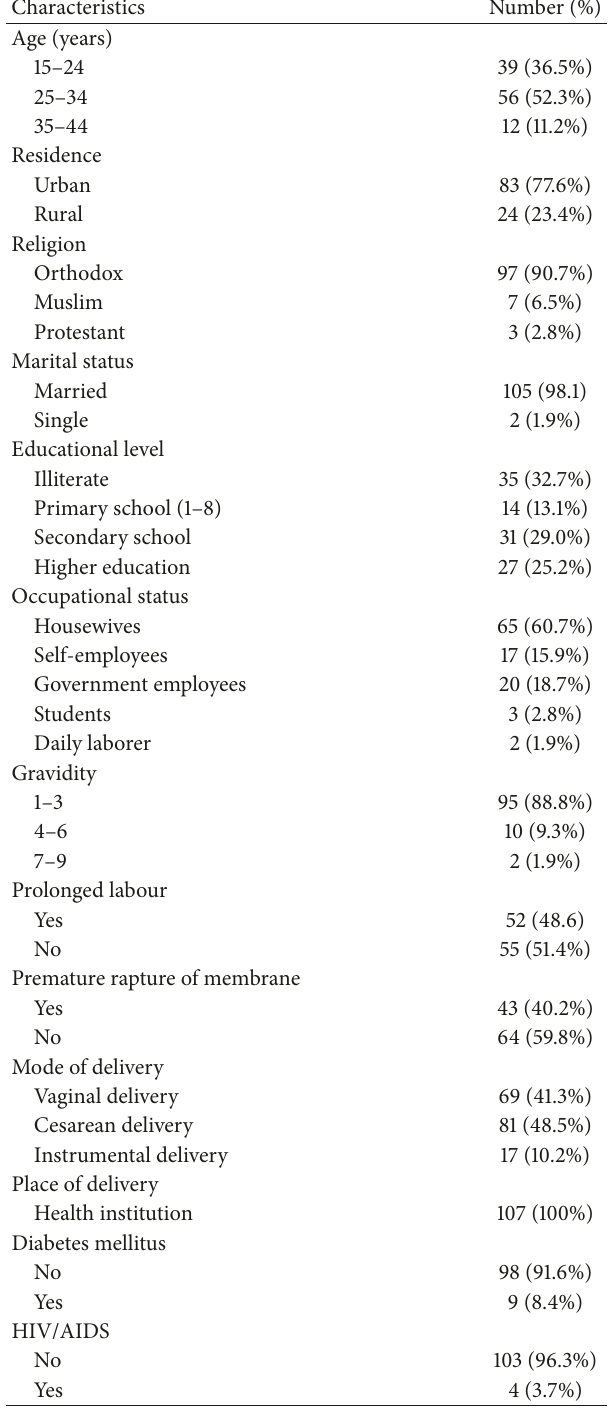
Table 1: Sociodemographic, obstetric, and clinical variables from women attending antenatal and postnatal services at the University of Gondar Teaching Hospital from 1 January 2016 to 30 May